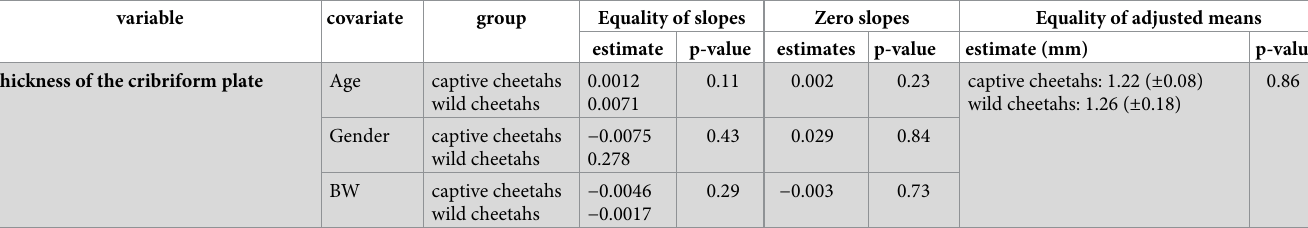
Table 2. Results of pairwise parametric (nasal bone, palatum thickness, occipital) and non-parametric testing of bone thickness at different measure points on the skull of clinically sound cheetahs and animals with overt hypovitaminosis A. Group